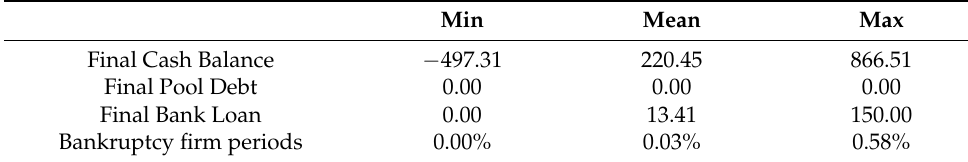
Table 13. Results for diverse operational risk and loan limits without